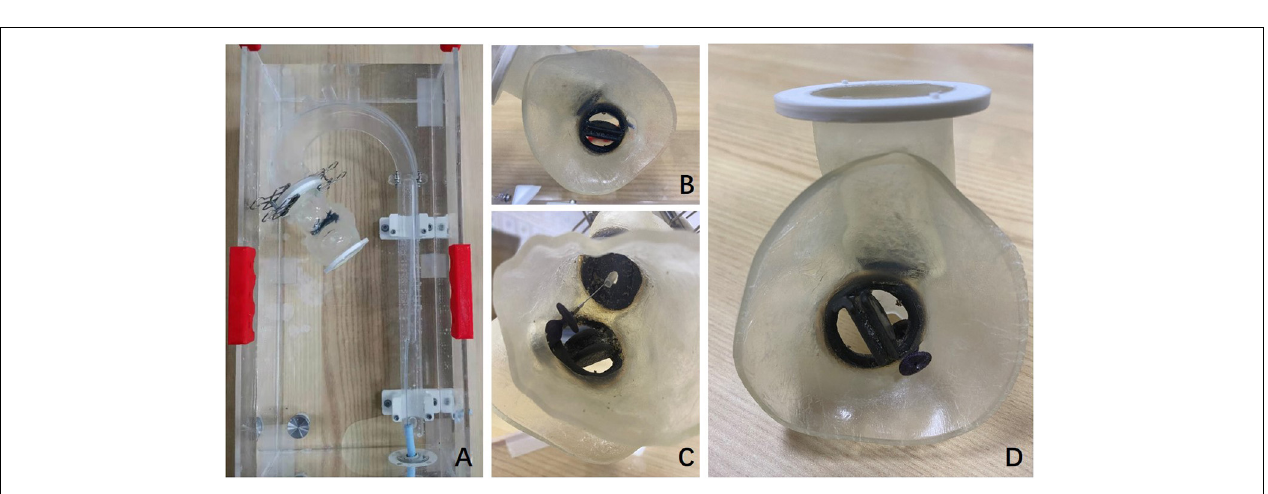
FIGURE 2 | The TTE and transesophageal echocardiographic (TEE) scans taken before the procedure. (A) TEE shows the aortic paravalvular leakage (PVL) before the procedure. (B) 3-Dimensional (3D)-TEE shows the aortic PVL before the procedure. (C) 3D-TEE shows the mitral PVL before the procedure. (D) The mitral PVL as seen on the TEE scan. (E) The mitral PVL as seen on the TTE scan. (F) The mitral PVL was as seen on TTE.